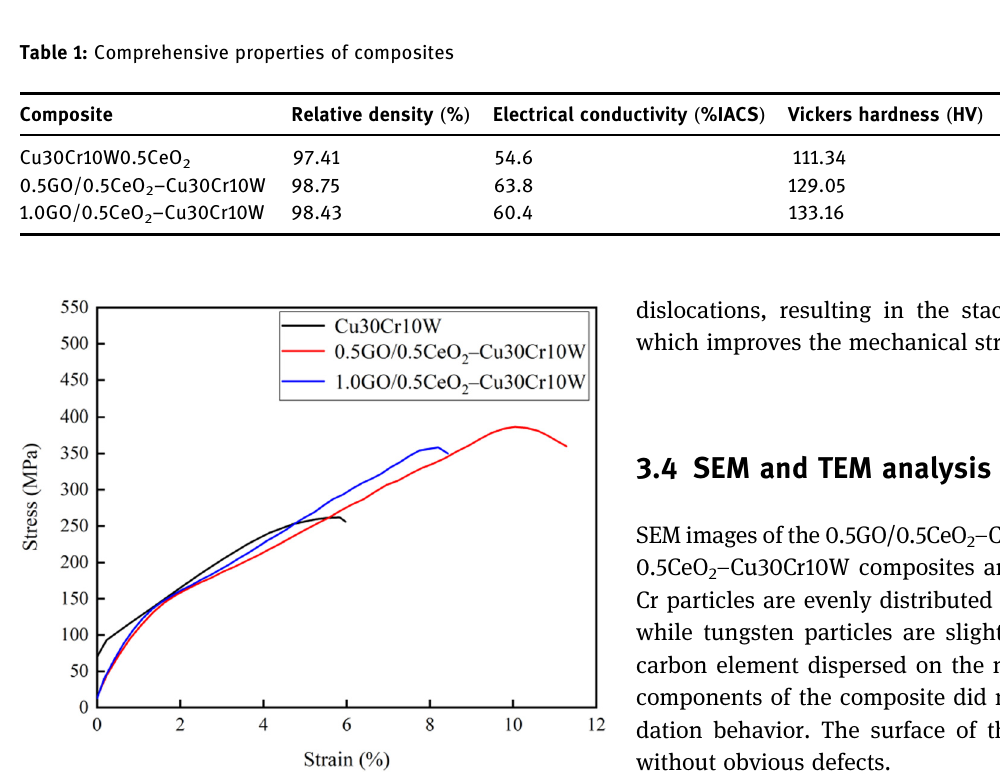
Figure 3: XPS analysis of the two as - sintered composites: ( a ) XPS spectra of GO and two kinds of composites; peak separation fi tting of C 1s spectrum of ( b ) GO, ( c ) 0.5GO/0.5CeO 2 – Cu30Cr10W, and ( d ) 1.0GO/0.5CeO 2 – Cu30Cr10W; O 1s spectra of GO ( e ) and composites ( f ) .